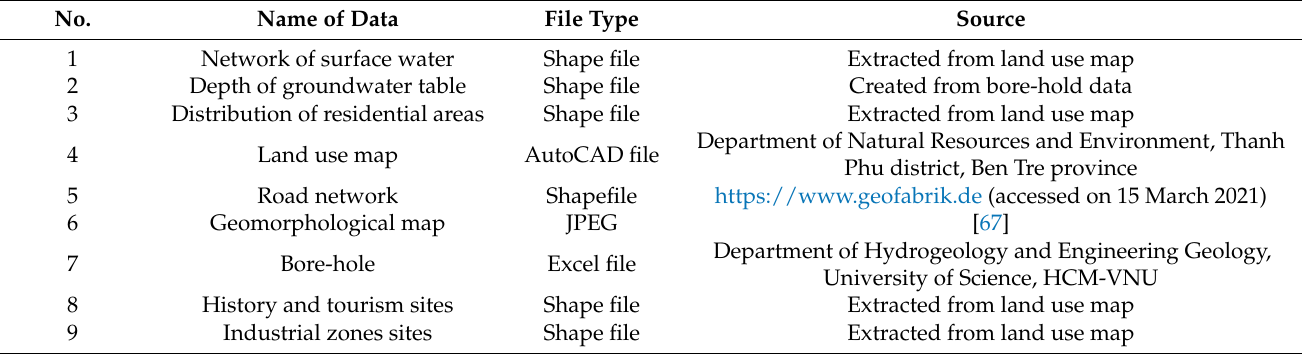
Table 1. Collected